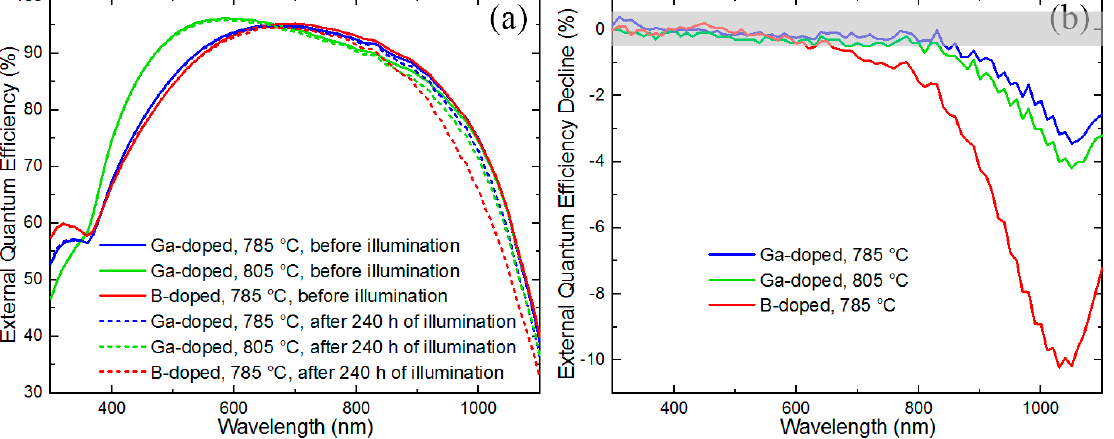
Figure 5. ( a ) External quantum efficiency curves of mc-Si PERC solar cells with different dopants (i.e., boron or gallium) and sintering peak temperatures (i.e., 785 or 805 °C) before and after 240 h of illumination. ( b ) Calculated external quantum efficiency decline curves. The grey area represents the fluctuation range ( ± 0.5%), in which the value change is considered as the measurement tolerance.